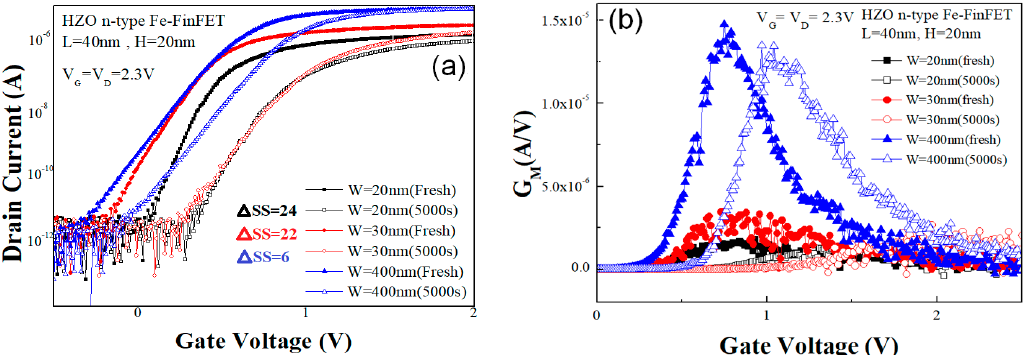
Figure 3. Hot-carrier-induced ( a ) I D -V G characteristics and ( b ) transconductance degradations for various fin-widths of n − type Fe-FinFET.